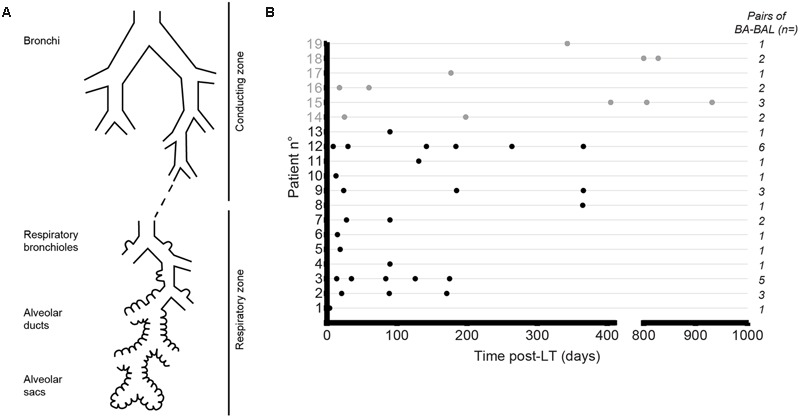
Collection of bronchial aspirate–bronchoalveolar lavage (BA–BAL) pairs from lung-transplant recipients. (A) Both zones were explored during the same procedure, with the conducting zone being sampled by performing a BA and the respiratory zone by BAL. (B) Dots represent BA–BAL pairs collected for each of the 19 patients after lung-transplantation. Gray dots refer to CF patients, whereas black dots depict non-CF patients.